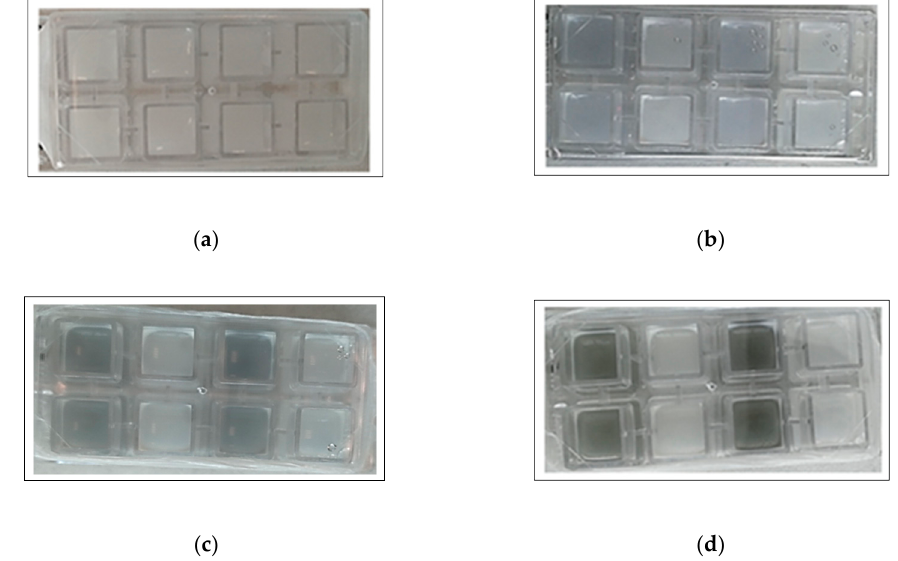
Figure 6. Blue pigment color evolution during the CLSM analysis using the Nunc wells: ( a ) 48 h, ( b ) 72 h, ( c ) 96 h, and ( d ) 168 h.